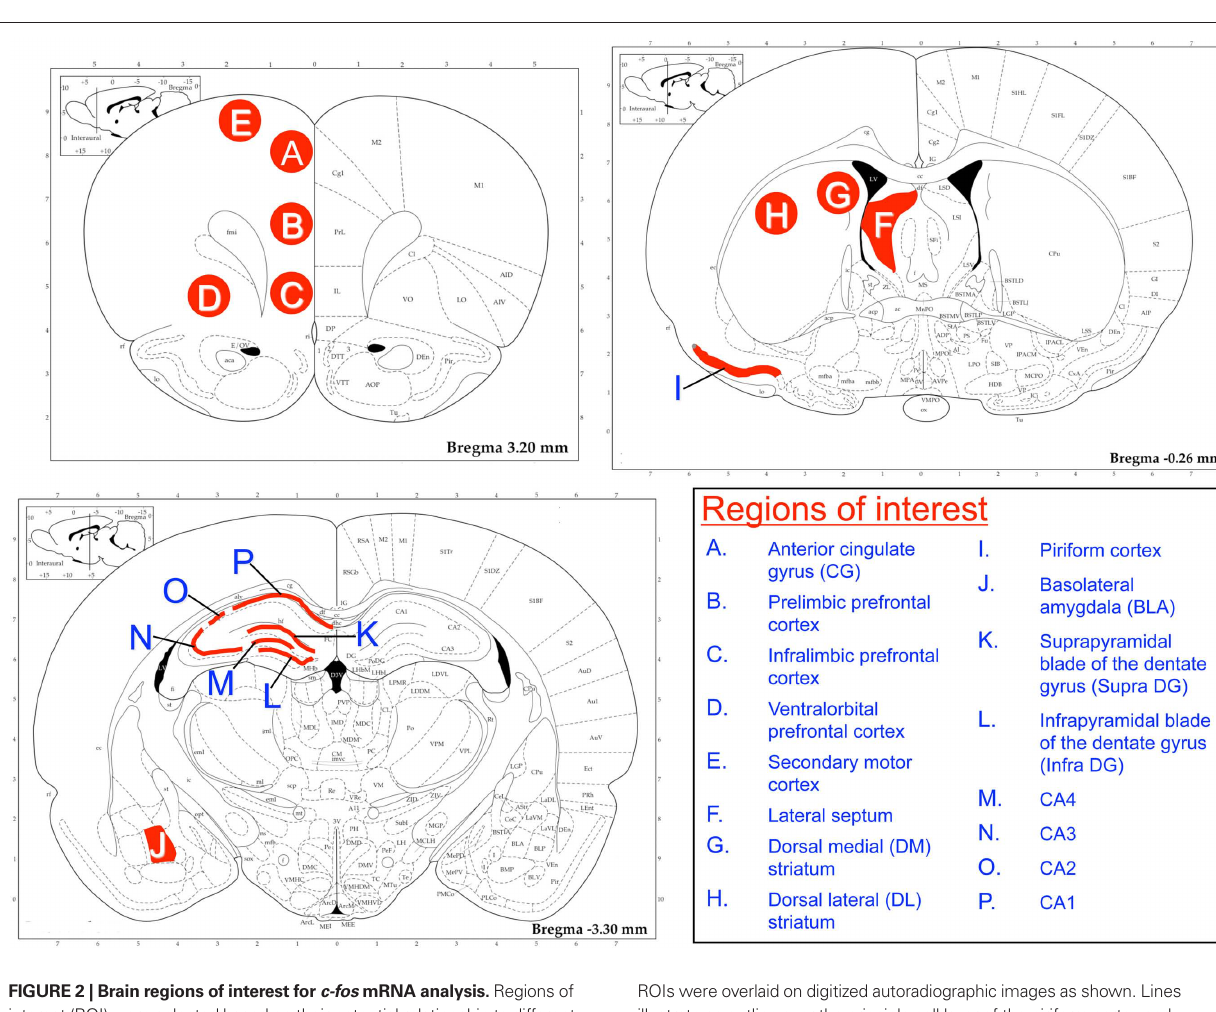
Figure 2 | Brain regions of interest for c-fos mrNA analysis. Regions of interest (ROI) were selected based on their potential relationship to different aspects of the RAWM task, such as stress and anxiety (prefrontal regions, septum, and amygdala), swimming and sensory processing (secondary motor cortex and piriform cortex) and memory (hippocampal subregions, amygdala).